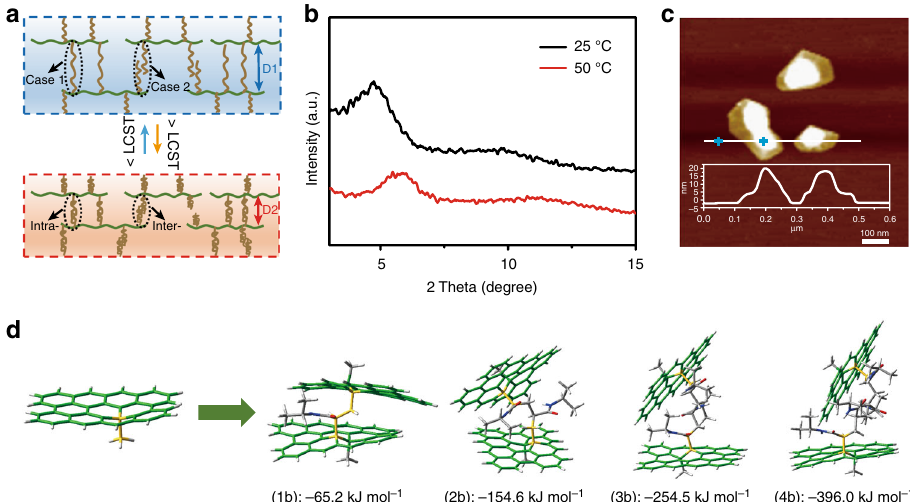
Fig. 4 Mechanism of the negative temperature-response behavior of P-GOMs. a Schematic diagram of the channel size change of P-GOMs from D1 to D2 caused by the swelling or shrinking of PNIPAM chains covalent bound to GO sheets. Case 1: PNIPAM chains grow from one GO sheet and terminate at another GO sheet. Intramolecular hydrogen bonding is formed when the temperature is above its LCST. Case 2: PNIPAM chains grow from one GO sheet and terminate freely. Intermolecular hydrogen bonding is formed when the temperature is above its LCST. b The XRD patterns of P-GOMs at 25 °C and 50 °C. The right shift of the diffraction peak indicates the smaller lamellar distance at 50 °C than 25 °C. c The AFM image of P-GO. The height of cross- sectional pro fi le proves that the P-GO sheets would like to stack together at 50 °C. d Optimized geometries of [C 36 H 16 -CH 3 ] (cid:129) and the representative